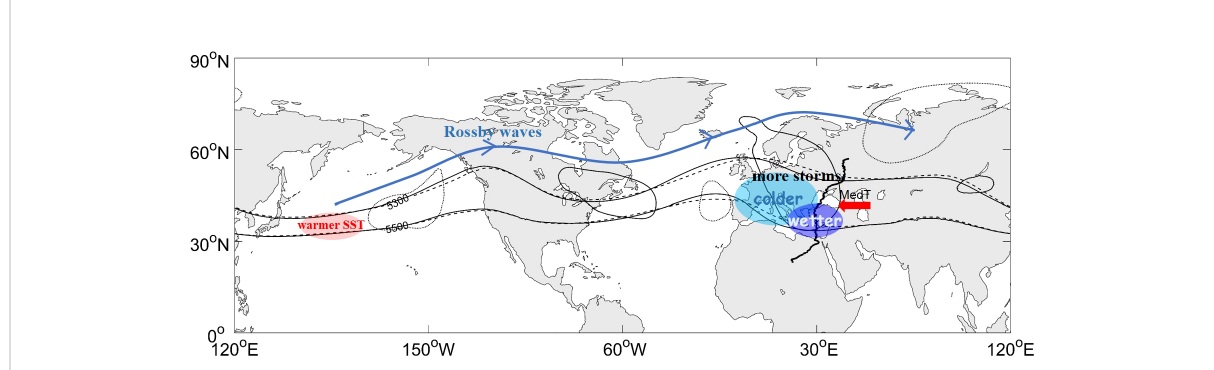
FIGURE 11 Schematic illustration of the dynamic relationship between the KE and MedT and associated winter climate. In the positive phase of KE, the warmer SST triggers a cyclone anomaly over Europe via the physical processes of Rossby waves and eddy – mean fl ow interaction. As a result, the MedT tends to be deeper and westward-positioned compared to its climatological state, bringing colder air advection to its western side and more precipitation to the northeastern Mediterranean Sea and Anatolia Peninsula. These tendencies reverse in the negative phase of KE. KE, Kuroshio Extension; MedT, Mediterranean trough; SST, sea surface